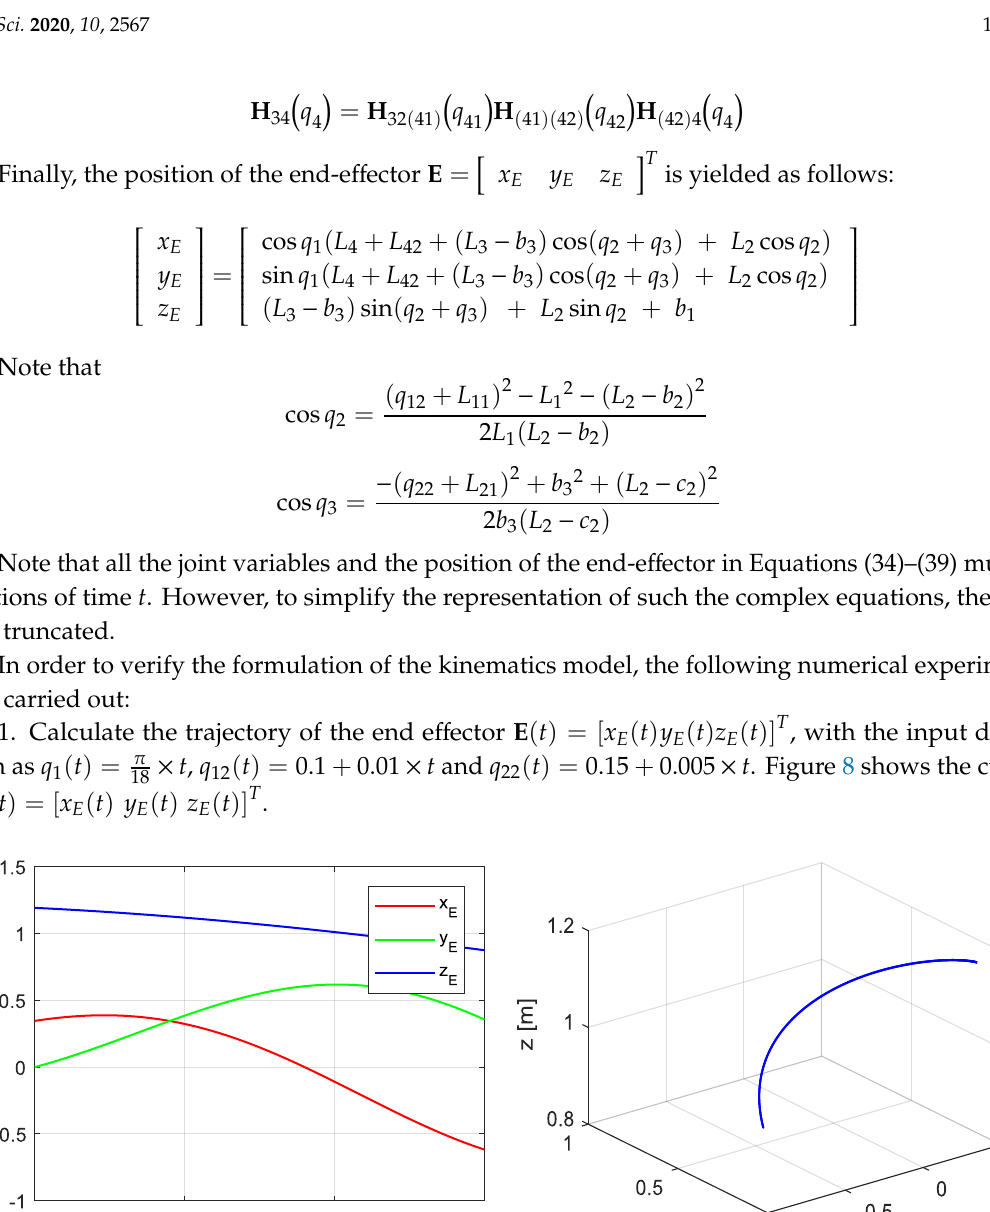
Figure 8. The trajectory of the end-effector.